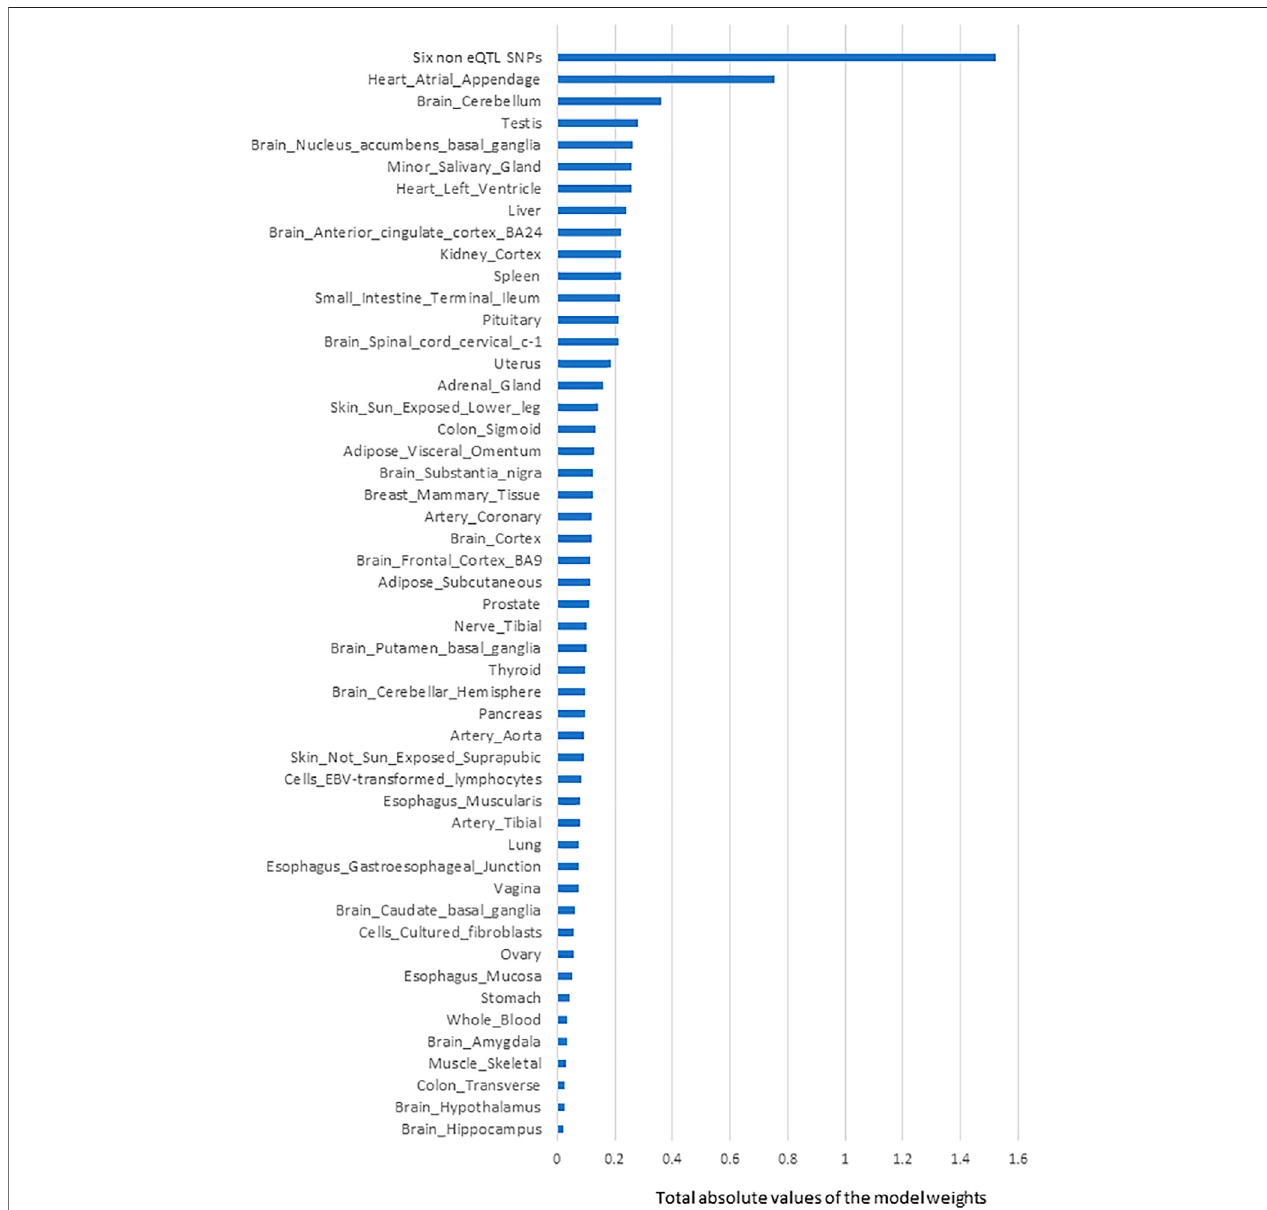
FIGURE2 | The rankorder oftissue-speci fi c riskcontributionstorisk ofdeveloping PDcalculated using model-1.TissuePD riskcontributionswere thesum ofthe absolute values of the model weights (coef fi cients) of the features used in the logistic regression predictor (model-1) according to their tissues. The SNPs/eQTLs that contributed to each category are listed ( Supplementary Table S5